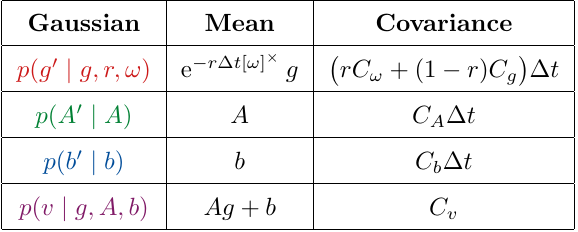
Table 2: Probabilistic specification of each dependency shown graphically in Figure 2. The operator [ · ] × expresses a 3-vector as a skew-symmetric matrix, the exponential of which is efficiently computed via the Rodrigues rotation